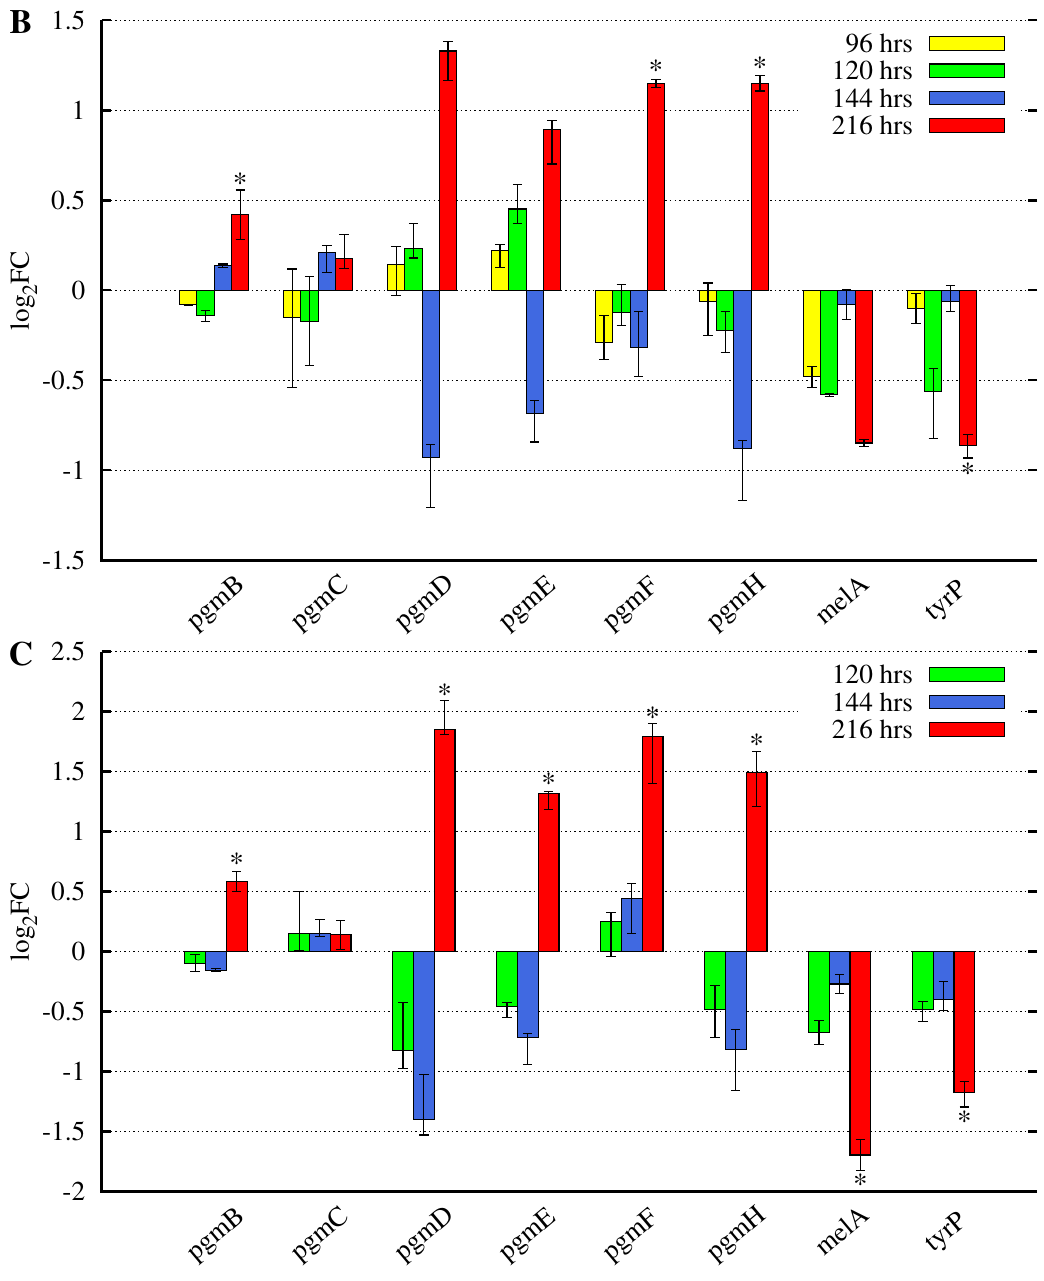
Figure 3. Gene expression analysis of the A. terreus pgm PKS cluster and asp-melanin genes under influence of butyrolactone I. Exogenous butyrolactone I was added to the submerged culture of A. terreus MUCL 38669 at ( A ) 24 h; ( B ) 96 h; and ( C ) 120 h p.i. to the final concentration of 100 nM. The lack of some cluster genes is due to the nucleotide level differences between strains MUCL 38669 and NIH2624 or the low transcript coverage obtained. The bars represent the median values of the log 2 FC of treated samples (butyrolactone I was added) versus control samples (no butyrolactone I added) and the error bars represent the maxima and minima of these log 2 FC values. * At least one of the technical replicates indicates statistically significant up- or downregulation of the three biological replicates (adjusted p -value ≤ 0.05 and | log 2 FC | ≥ 0.5). a The apparently statistically significant upregulation at 24 h post inoculation may not be biologically significant due to the low culture density at the start of exponential growth